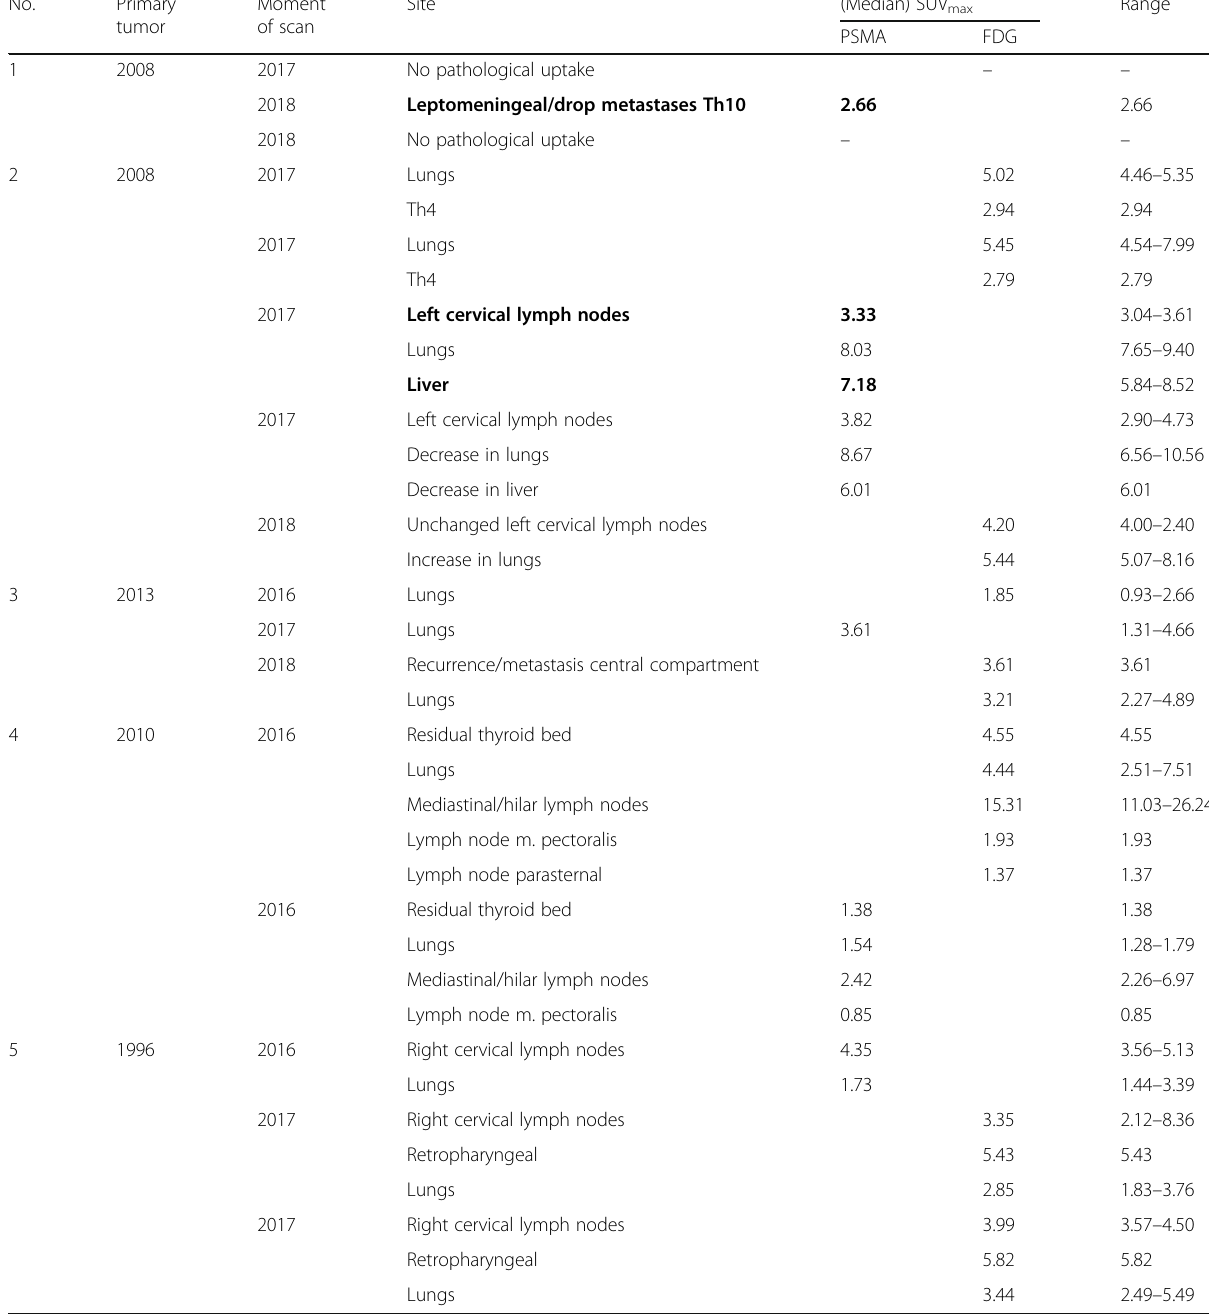
Table 2 Results of 68 Ga-PSMA PET/CT and 18 FDG